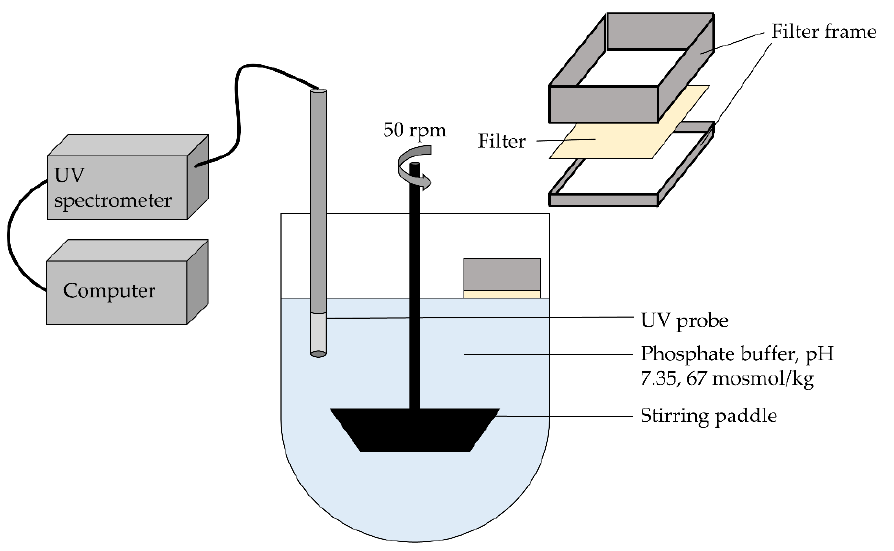
Figure 3. Setup for dissolution testing of the oral films, modified from Krampe et al. [43] with kind permission from Elsevier.